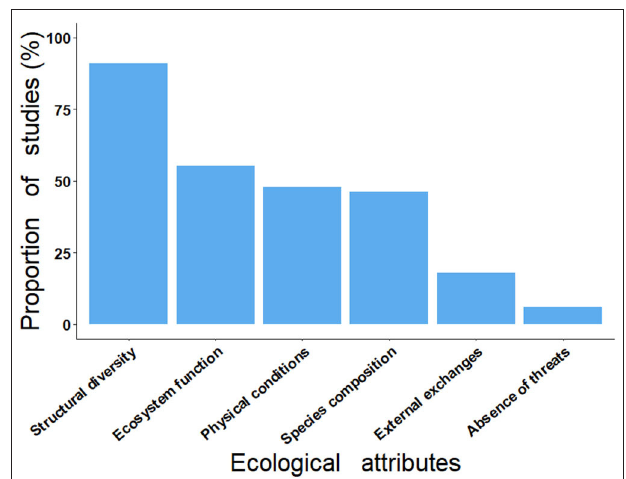
FIGURE 2 | Proportion of the studies investigating ecological